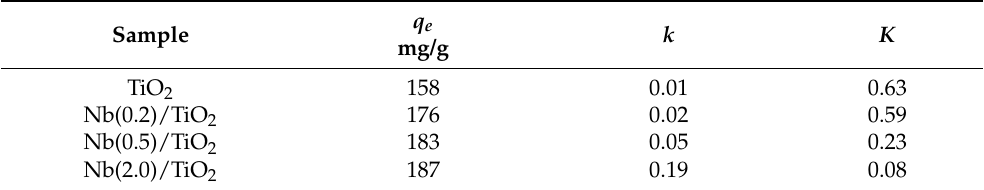
Table 1. First-order reaction rate constants ( k ) and the adsorption equilibrium constant ( K ), and calculated q e values.